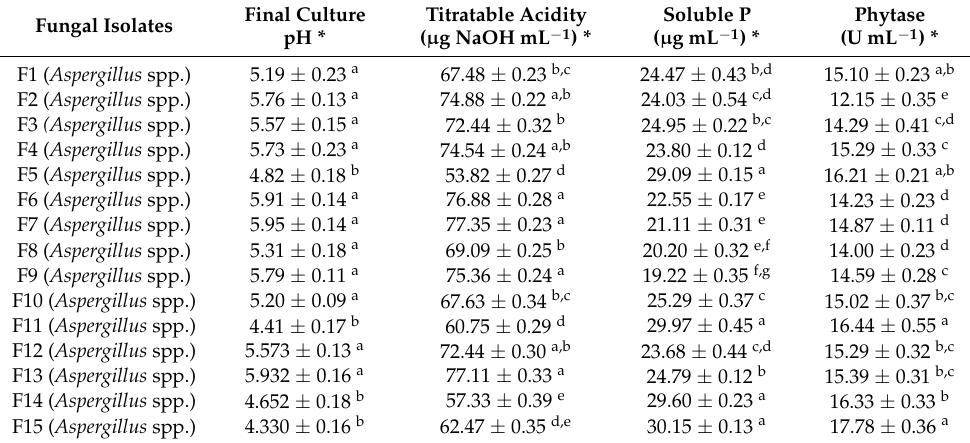
Table 2. Bio-solubilization of rock phosphate by different Aspergillus spp. Final Culture Fungal Isolates pH